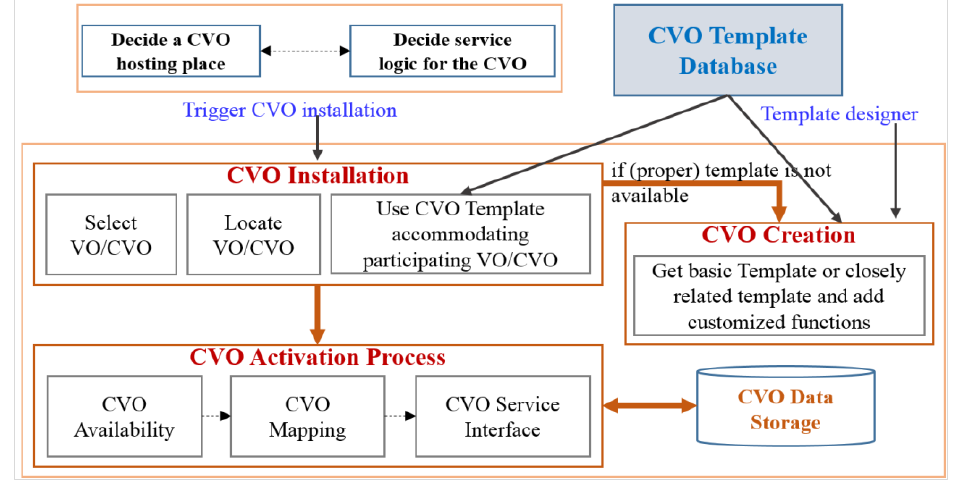
Figure 4. CVO creation and activation process at the CVO level to offer user requested